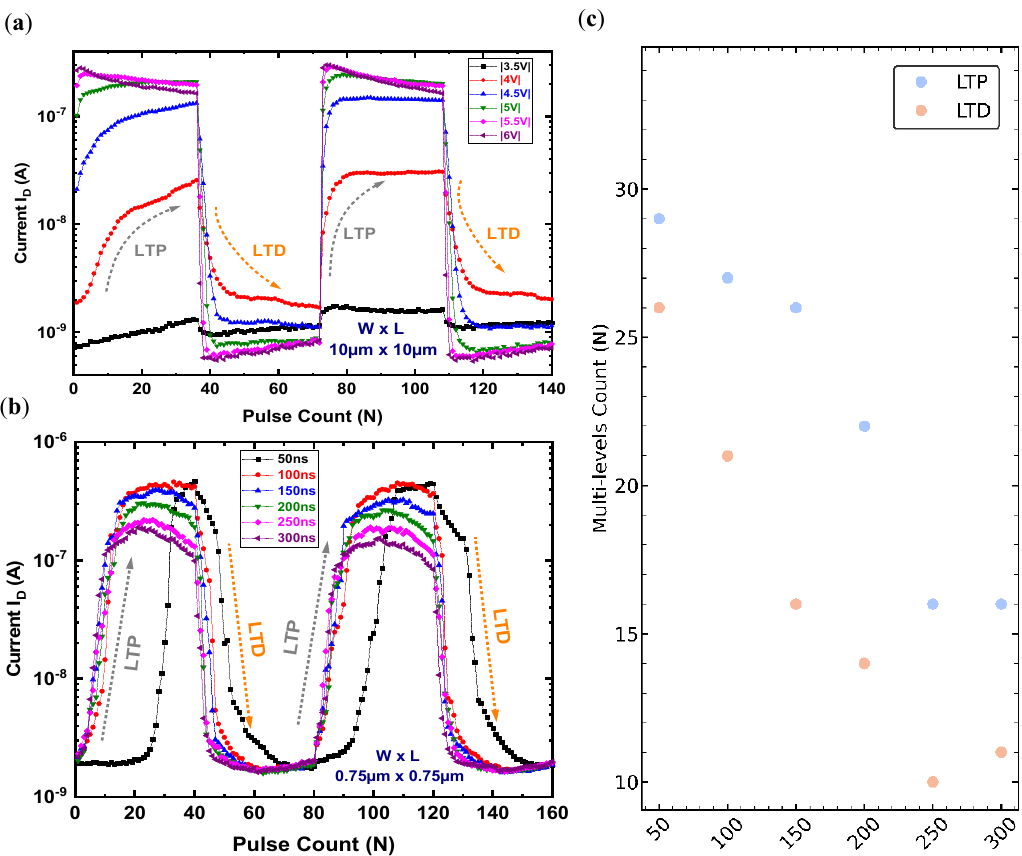
Figure 19. The FeFET synaptic LTP/LTD using ( a ) different amplitude conditions for the pulse width sweep (sequence 2), ( b ) different pulse width conditions for the amplitude sweep (sequence 3), ( c ) the impact of the pulse width sweep in sequence 3 on the multi-levels